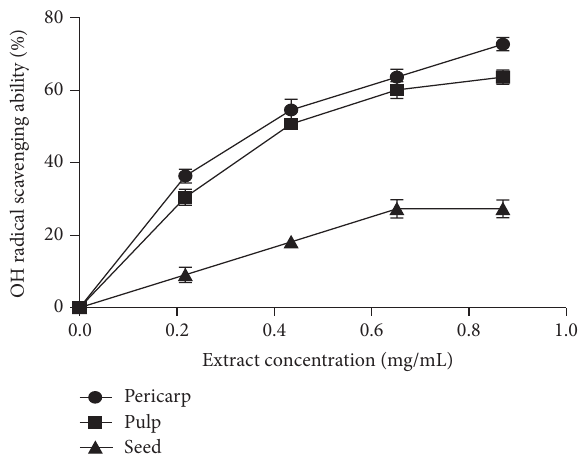
Figure 6: Hydroxyl (OH) radical scavenging ability (%) of the aqueous extracts of the pericarp, pulp, and seed of Soursop fruit.